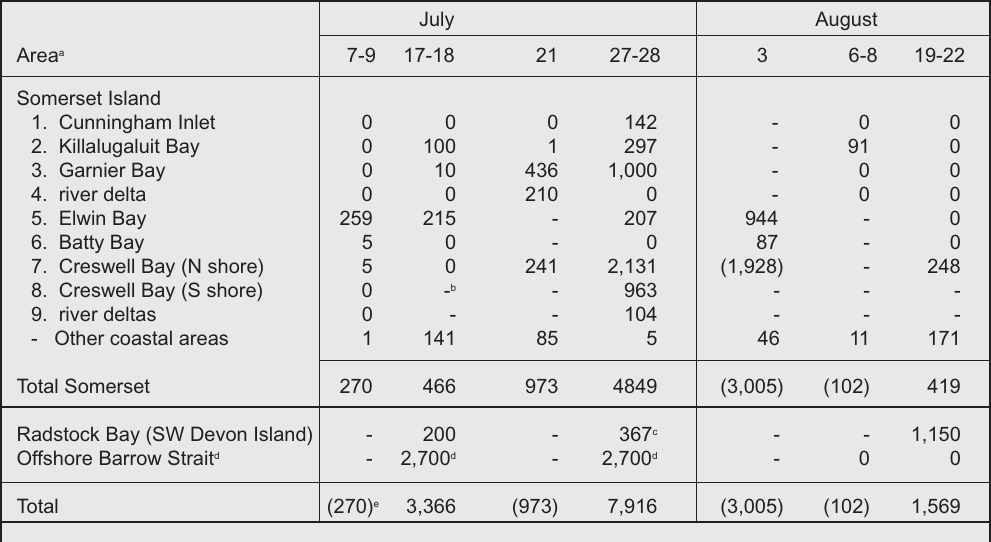
Table 4 . Numbers and distribution of belugas in the central Canadian High Arctic, July - August